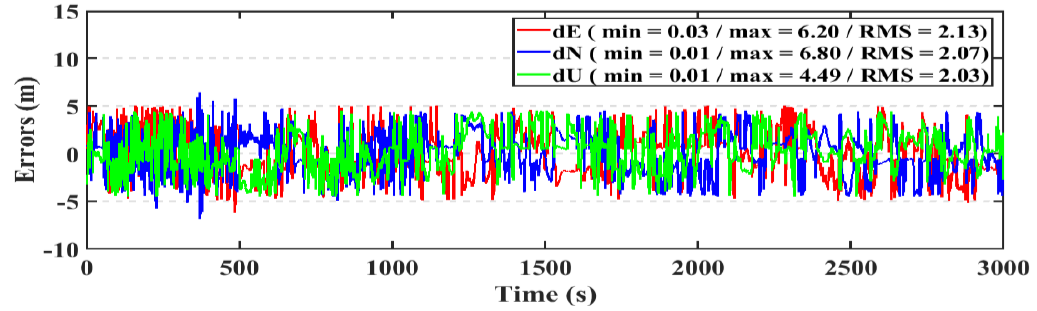
Figure 24. Position errors for the post-processed PPP solution (kinematic / second dataset).